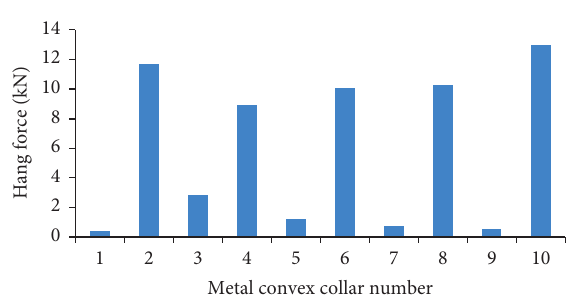
Figure 19: Hang force generated on each metal